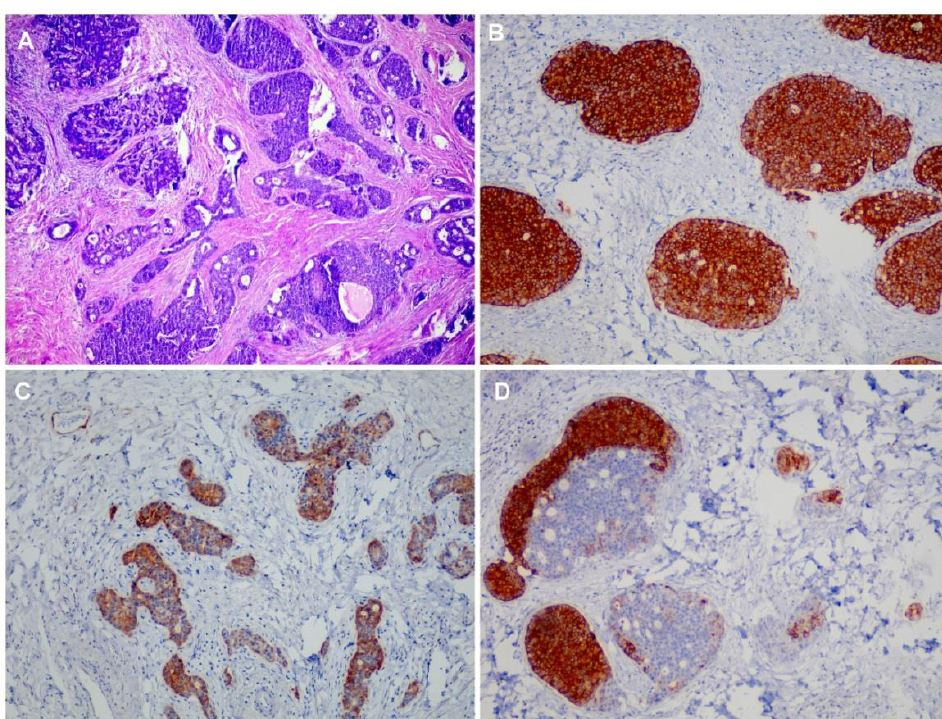
Figure 1. Microscopic findings of MiNEN in the stomach with the neuroendocrine component and epithelial part of the tumor: ( A ) H&E stain; ( B ) tumor cells marked by neuroendocrine marker synaptophysin; ( C ) immunohistochemistry for CK7; and ( D ) CK20 showing positivity for epithelial component—(20× magnification).